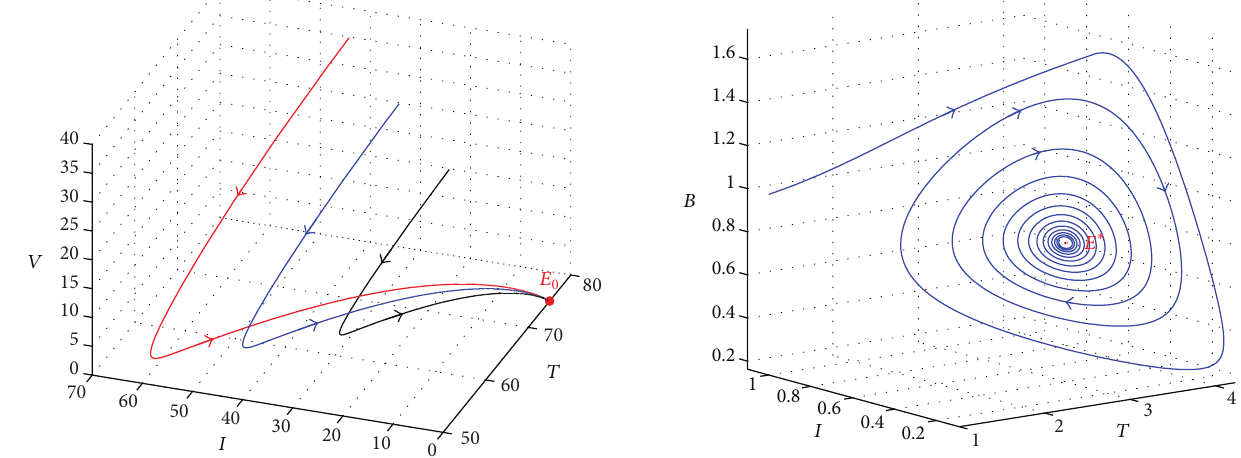
Figure 1: Equilibrium 𝐸 0 is globally asymptotically stable if 𝑅 0 < 1 .